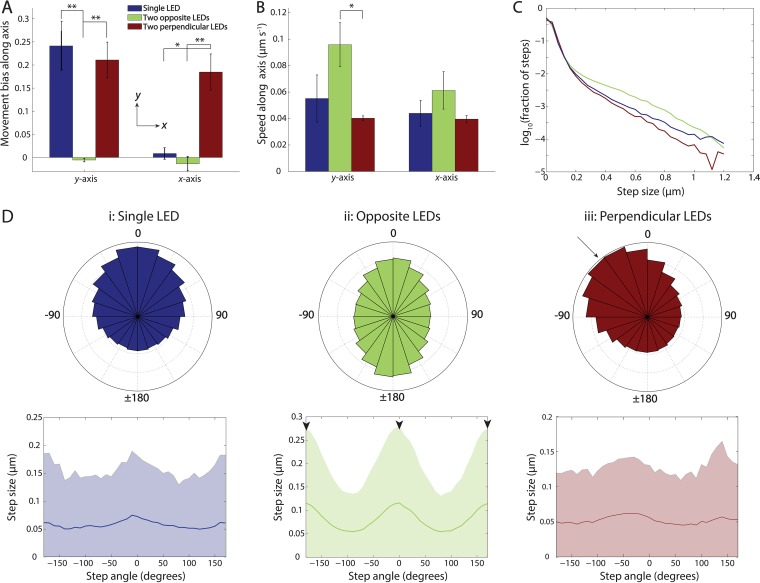
Light signals of equal intensity from opposite directions cancel light bias, while perpendicular signals induce a superposition of the two biases. (A) Movement bias along the x and y directions in the presence of various LED orientations. Motility bias was approximately 0 in both directions for two opposing LEDs; bias along the x and y axes in the presence of two perpendicular LEDs was similar to the y-direction bias of a single LED. Cells were imaged 24 h after inoculation. Error bars are standard error of the mean (n = 3 independent experiments). The statistical significance of differences in the means was determined using Student’s t test. *, P < 0.05; **, P < 0.01. (B) Single-cell speed along each axis did not significantly differ among all cases shown in panel A, except for the y direction for two opposing LEDs. *, P < 0.05. (C) Distribution of step sizes was similar for a single LED and two perpendicular LEDs, while cells took a higher fraction of larger step sizes in the presence of two opposing LEDs. The number of contributing cells was 951, 1,141, and 2,310 under each respective light condition. (D, top) By mapping steps to polar coordinates, distributions of single-cell step angles were found to be consistent with community behaviors. Concentric circles correspond to frequencies of 0.02, 0.04, 0.06, and 0.08. (Bottom) Step size as a function of step angle. Error bars indicate standard deviations of step sizes measured for steps in 10°-wide bins of angles. (i) In the presence of a single LED, cells take a larger fraction of steps toward the light, but step size is independent of step angle. (ii) In the presence of two opposing LEDs, cells increase the fraction of steps toward each LED, and step sizes are larger along the light axis (arrowheads). (iii) In the presence of two perpendicular LEDs, cells take a larger fraction of steps along the direction of the vector sum of the two light directions (arrow), and have a uniform distribution of step sizes as a function of step angles. The number of contributing cells was 951, 1,141, and 2,310 under each respective light condition.